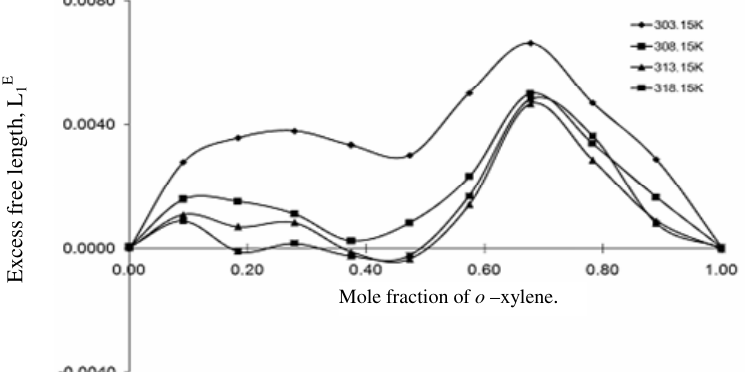
Mole fraction of o –xylene .